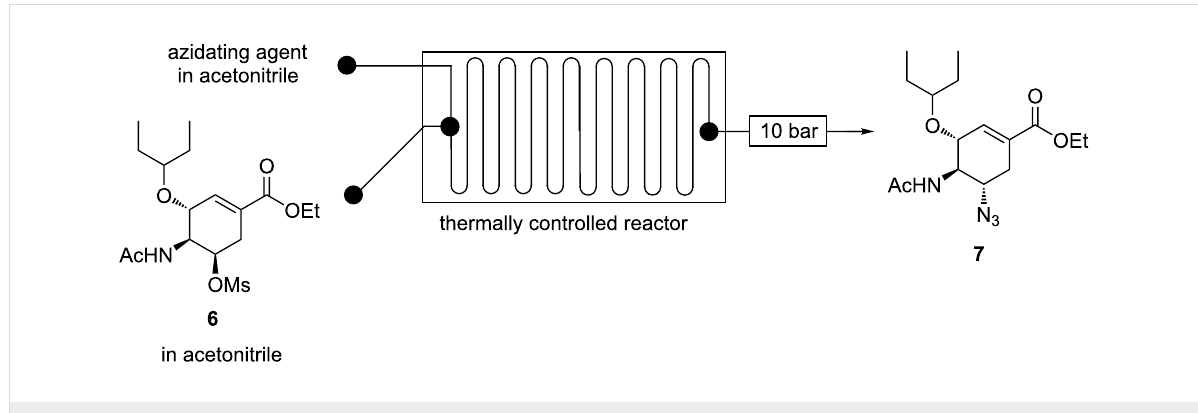
Figure 17: Continuous flow C-5 azidation of acetamide 6 using various azidating agents.